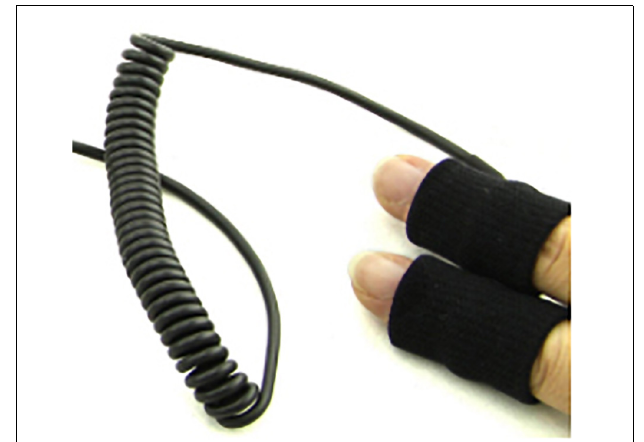
FIGURE 2 | Galvanic skin response sensor worn on the learner’s